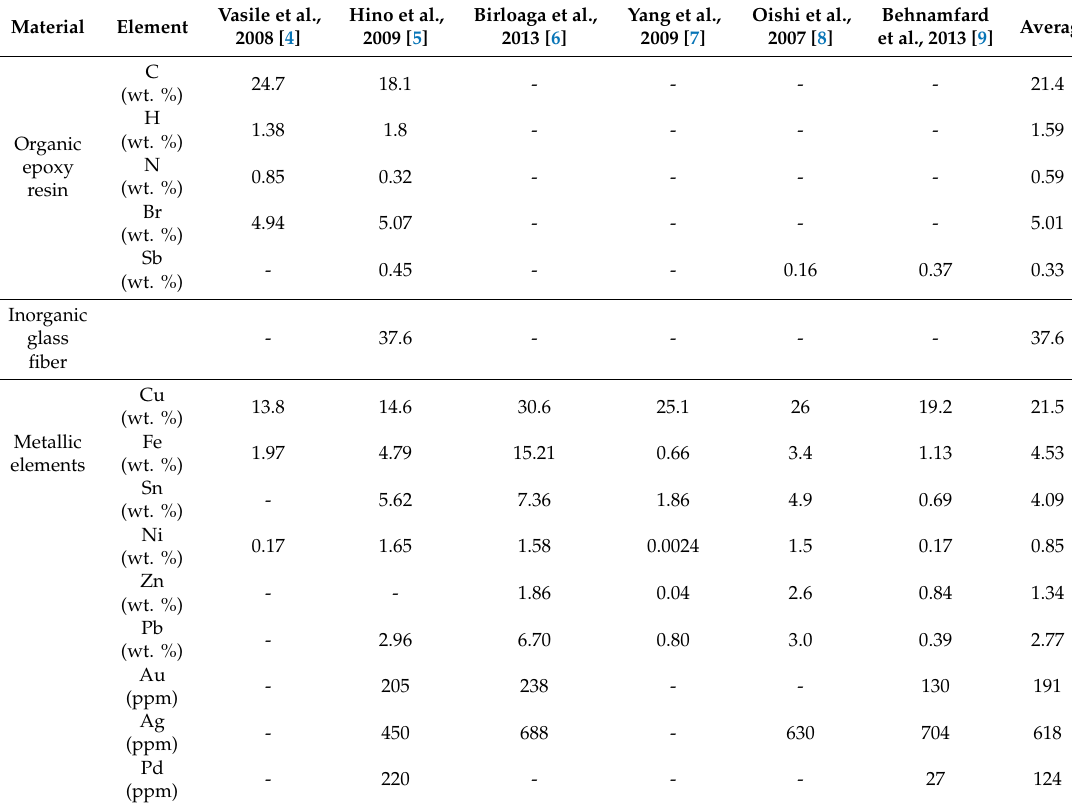
Table 1. Selected material composition of Waste Printed Circuit Boards (WPCBs).